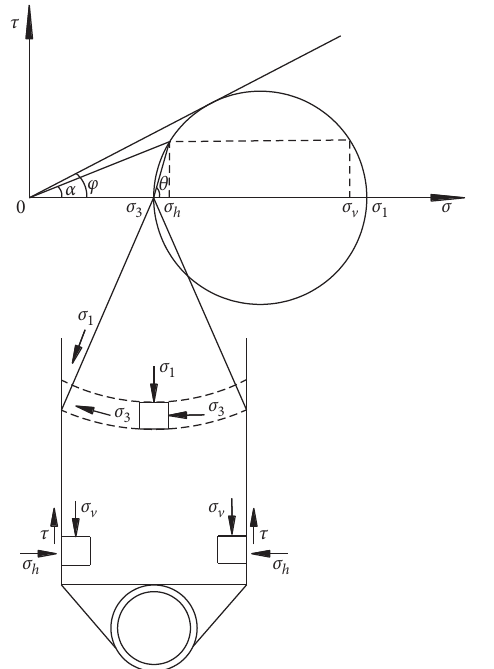
Figure 1: Sketch of partially developed soil arching effect.